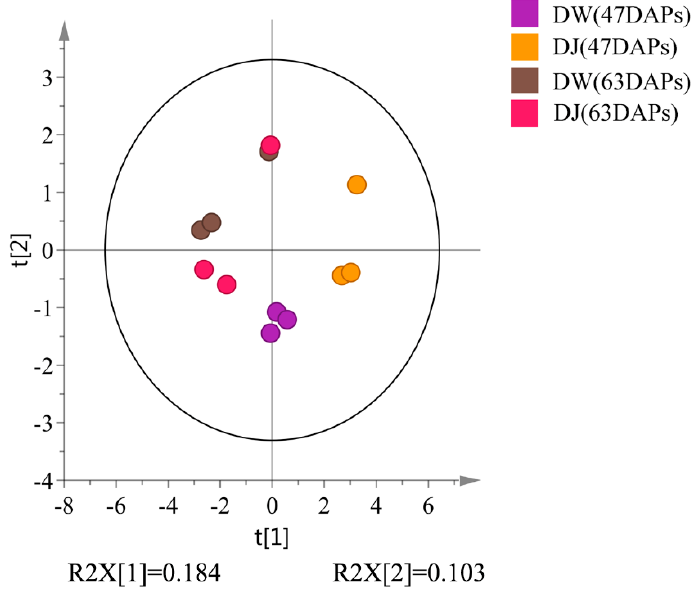
Figure 5. Principle component analysis (PCA) of the lignin metabolites derived from LC-MS.